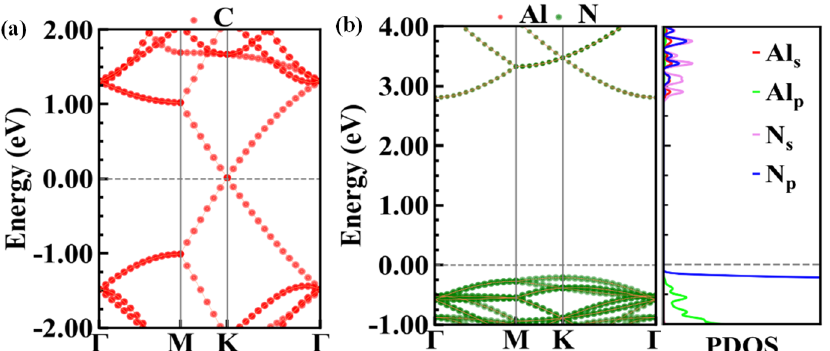
Figure 2. ( a ) The projected band structure of graphene, ( b ) the projected band structure and density states of 2D AlN.